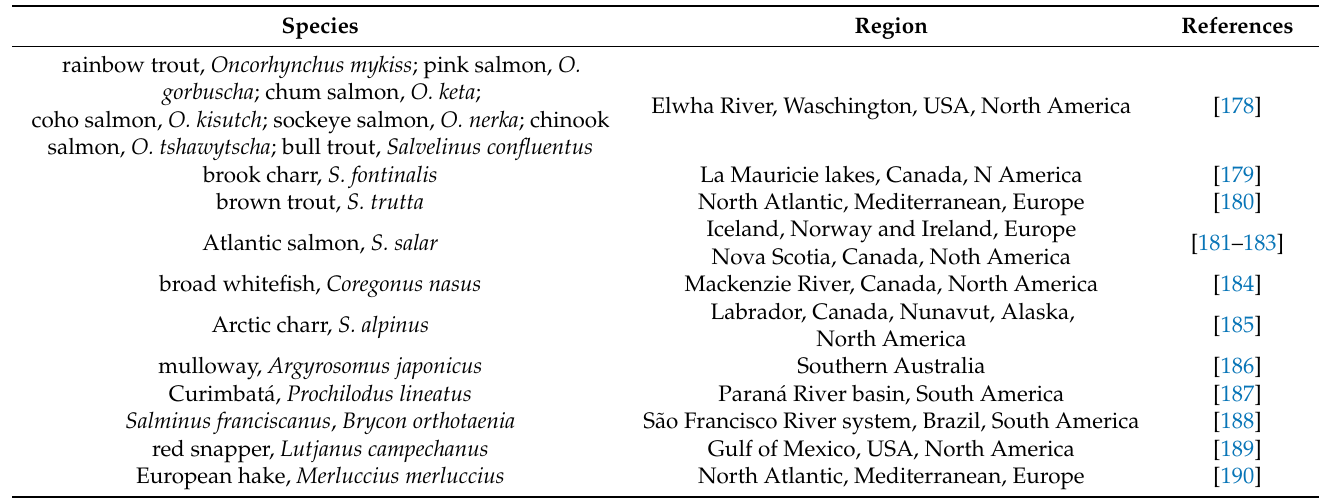
Table 3. Examples of species with population genetic structures found using microsatellites.